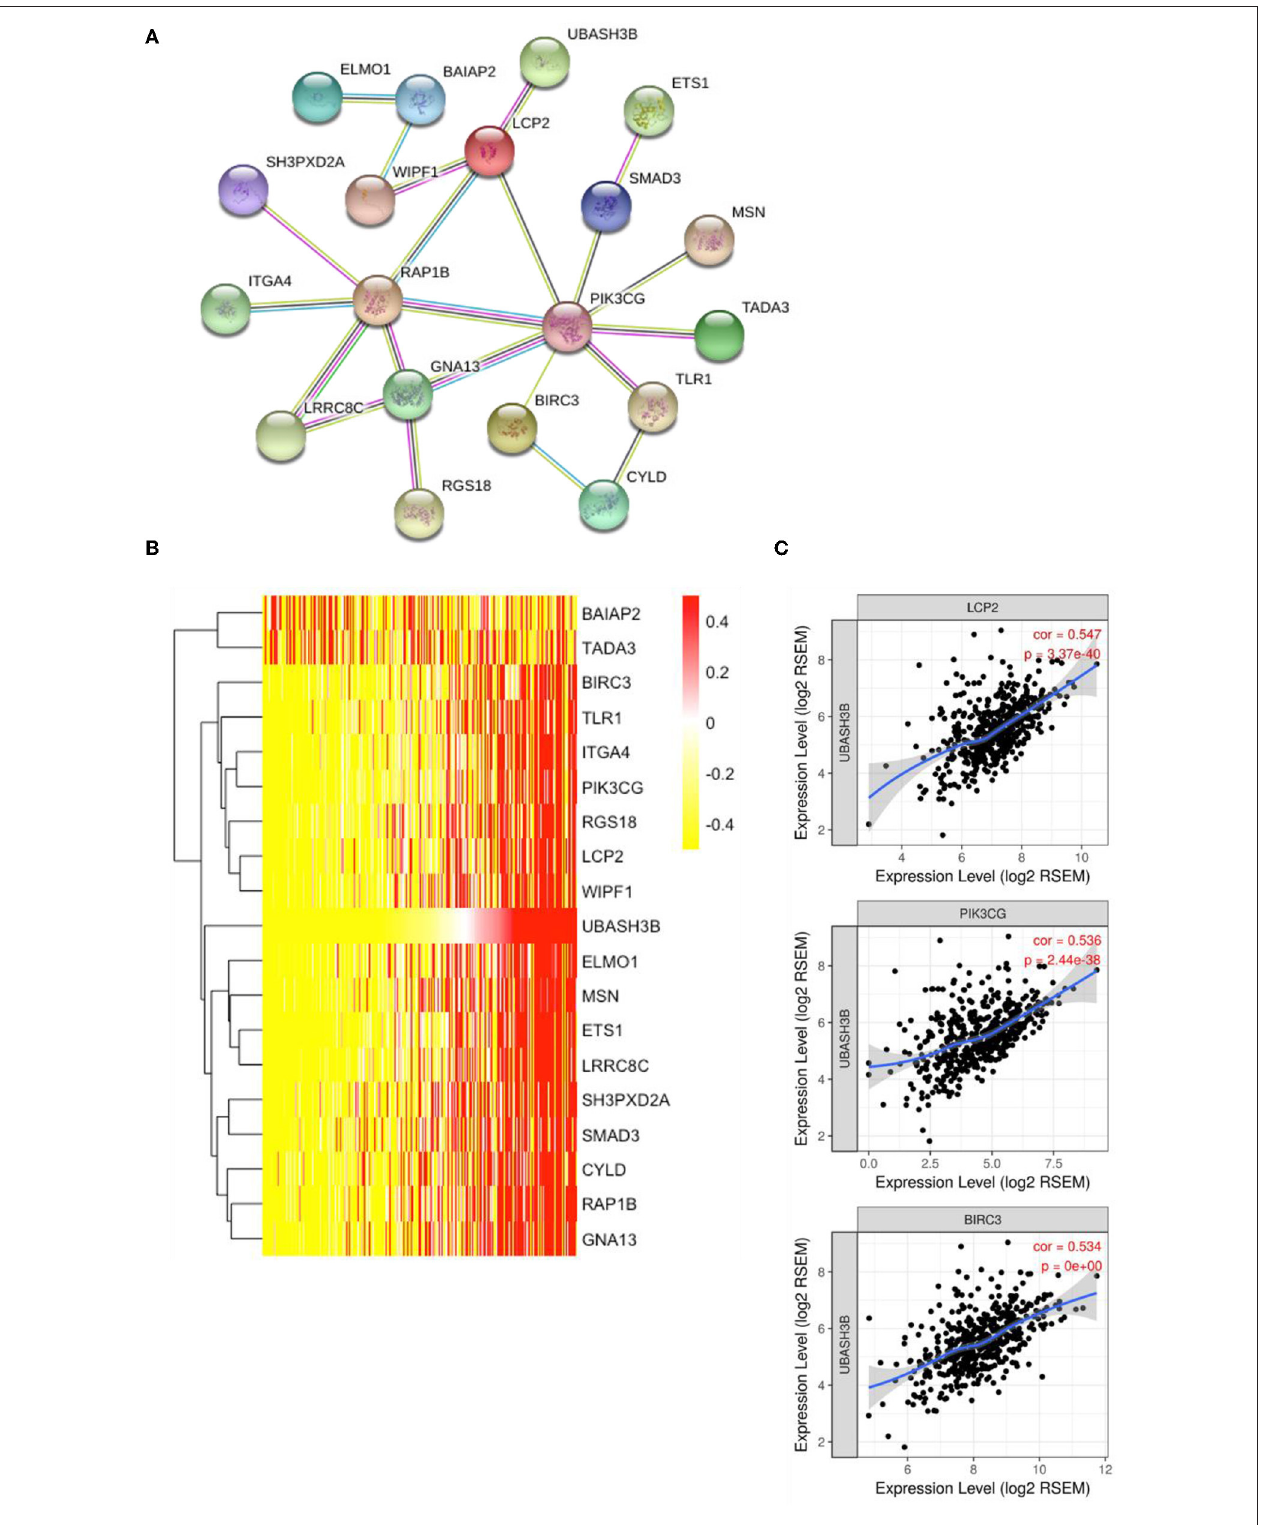
FIGURE 5 | (A) The top 50 genes of each phenotype in the GSEA single-gene method was used to construct the PPI network by STRING (https://string-db.org/) and 19 genes was mapped (medium confidence equals 0.400). (B) Heatmap of 19 genes is involved in PPI network. (C) UBASH3B is significantly correlated with LCP2 ( p = 3.37e-40, cor = 0.547), PIK3CG ( p = 2.44e-38, cor = 0.536), and BIRC3 ( p = 0, cor = 0.534) in prostate adenocarcinoma.